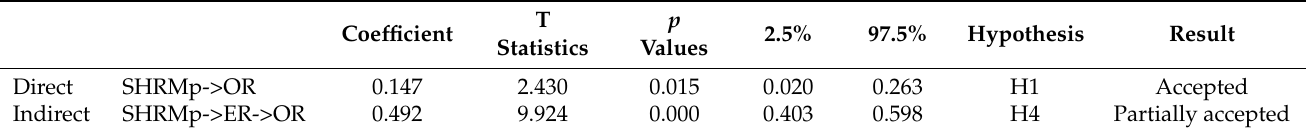
Table 7. Results of the mediation